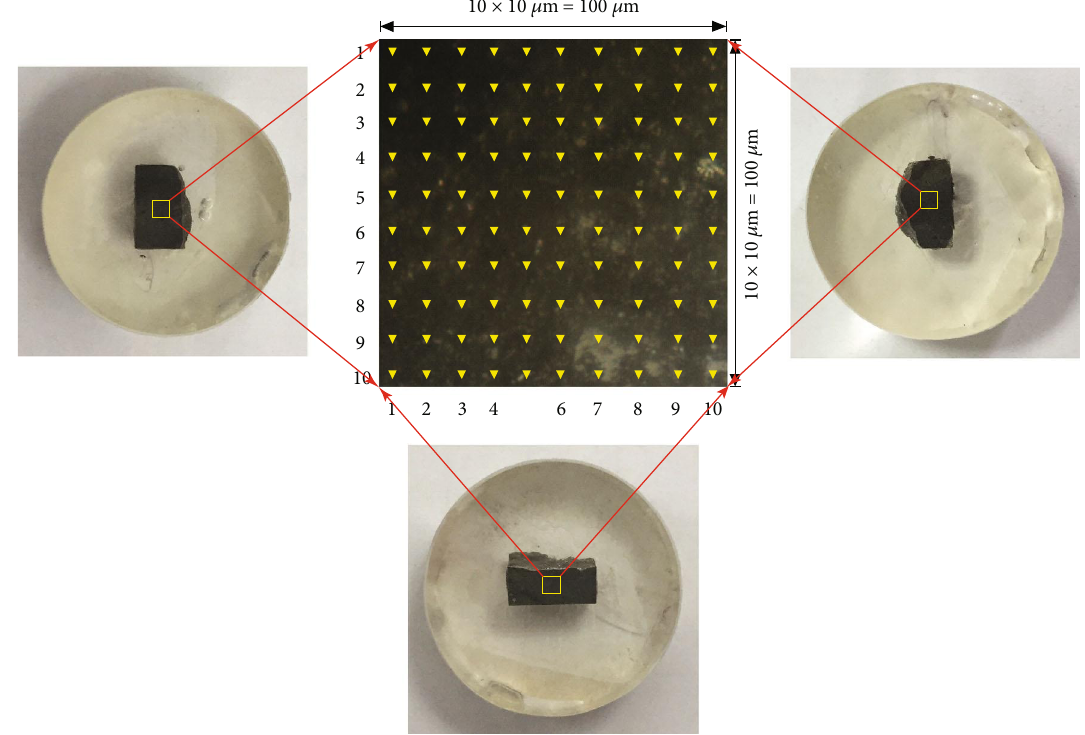
Figure 6: Indent arrangement on mudstone surface.